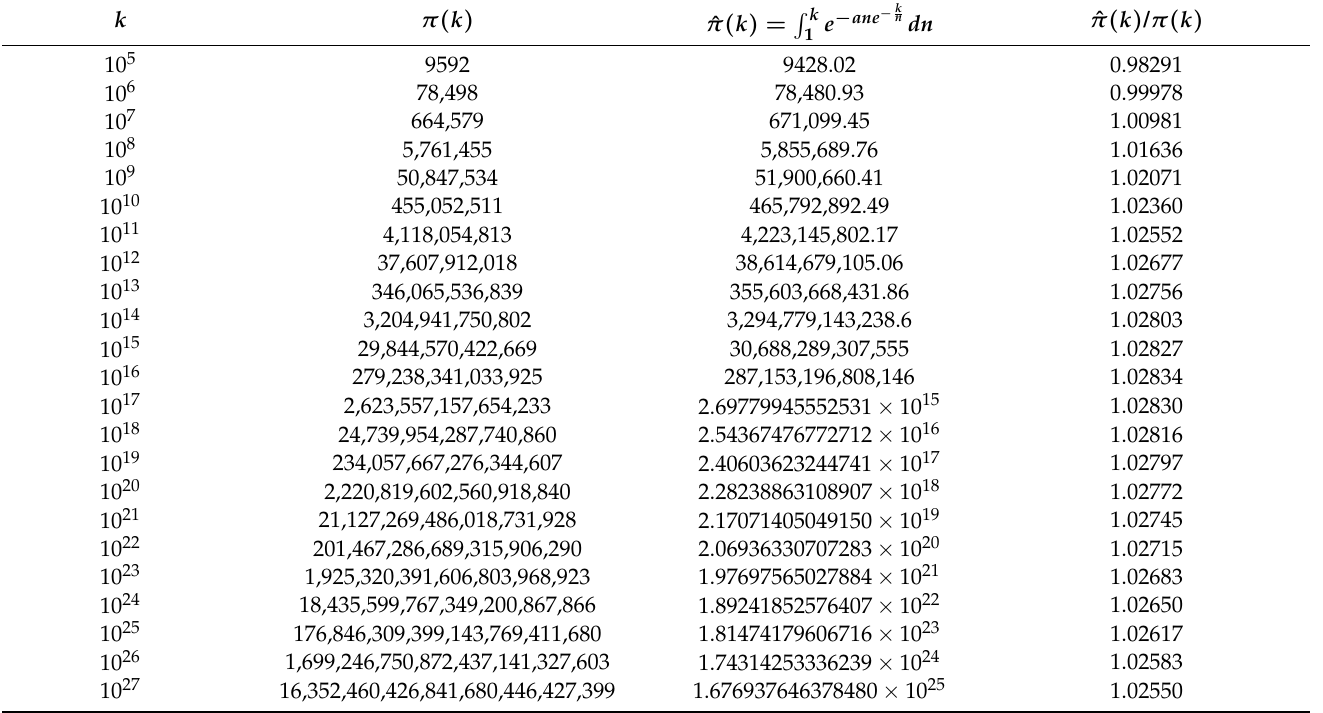
Table 4. ˆ π ( k ) estimate through continuous